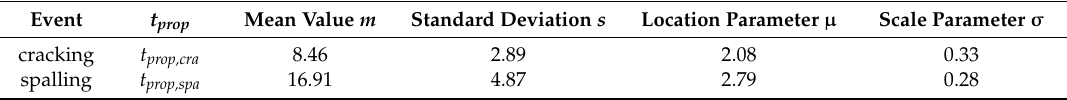
Table 16. Values of duration of propagation t prop until the occurrence of events of cracking and spalling for the wings of the Weikendorf Bridge.